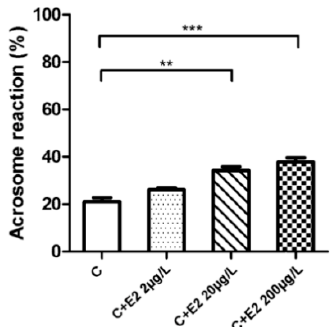
Figure 5. Acrosome reaction during 90 min capacitation (C) in presence of estradiol (E2). Sperm were capacitated in presence of E2 (C + E2 2; 20 and 200 µ g/L) or without E2 (control, C). The rate